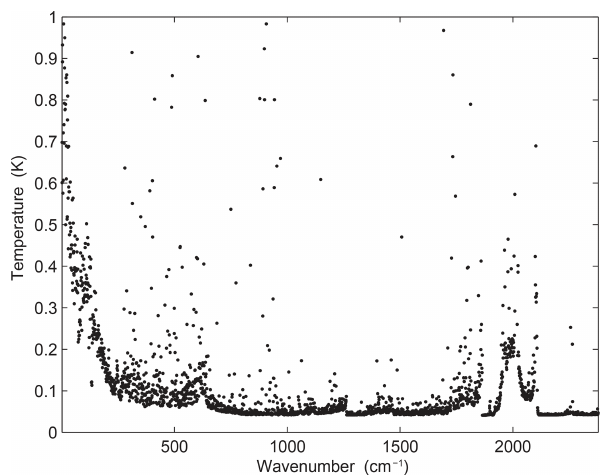
Figure 1. Root-mean-square error of AIRS infrared channel (black